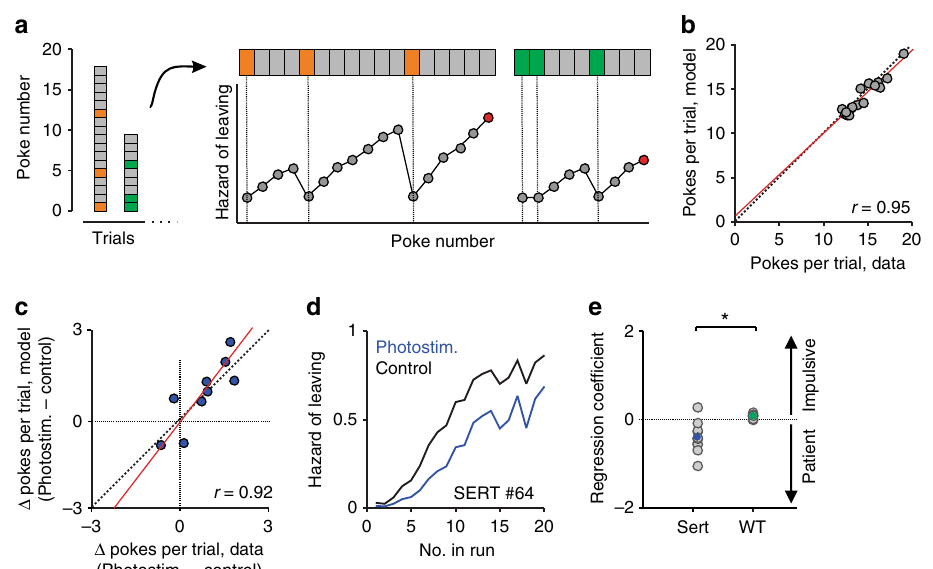
Fig. 5 Fitting behavioral data using the proportional hazards model. a Schematic drawing of proportional hazards model fi tting pipe-line for two example consecutive trials. Nose-pokes (pooled across trials and sessions for each mouse independently) were used to fi t a logistic regression model — the outcome of which was an estimated hazard rate that is reset at trial start and after each reward and is multiplicatively changed by the different coef fi cients ’ values. This hazard rate can be viewed as an estimate of the probability of leaving after each nose-poke and can therefore be used to simulate mouse leaving decisions. Leaving decisions depicted as red circles. b Scatter plot of simulated vs. real average number of nose-pokes per trial. Each circle represents one mouse ( n = 16). Dashed line is the unity diagonal and red line is a linear regression curve, with its correlation coef fi cient shown as well ( p < 0.001). c Same as b for the effect of photostimulation on the number of nose-pokes per trial ( p < 0.001). d The modeled hazard function for an example SERT-Cre mouse for phostostimulated and control nose-pokes. Note that decreased hazard means longer staying. e Cox regression photostimulation coef fi cient for SERT- Cre ( n = 10) and wild-type ( n = 6) mice. Averages across mice are shown in fi lled circles. * p < 0.05, Wilcoxon rank-sum